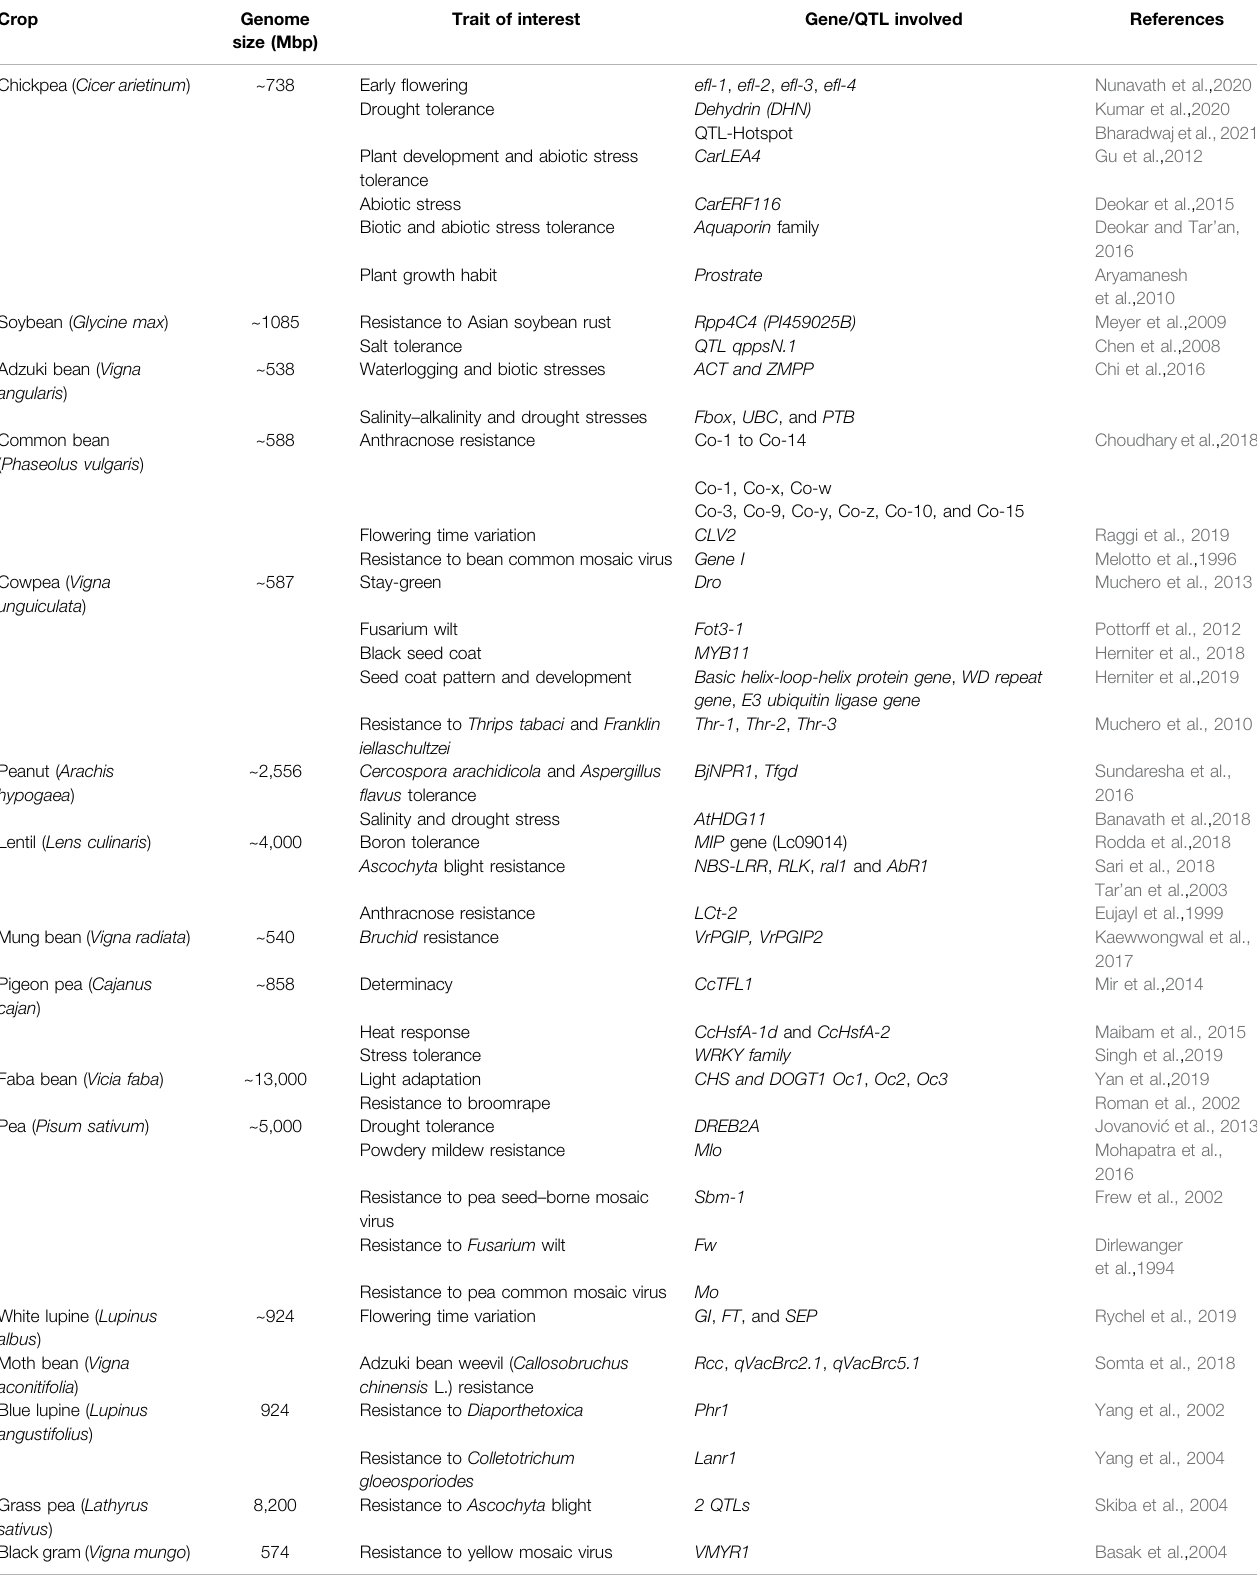
TABLE 1 | List of some of the prominent examples of domestication-related genes identi fi ed in food legume